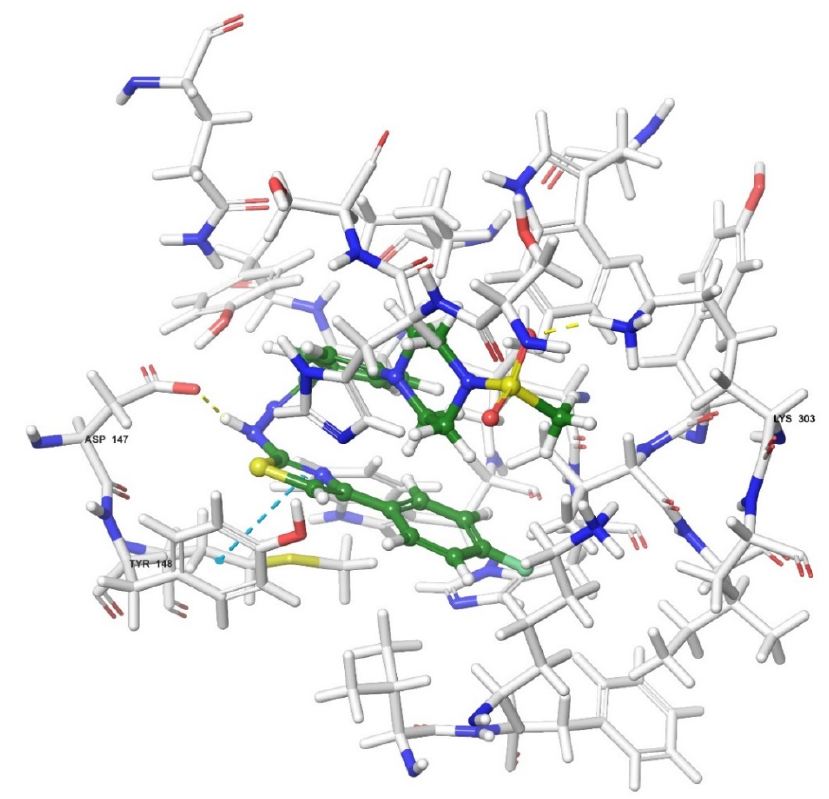
Figure 12. The three-dimensional interacting mode of compound 3f in the active region of µ -opioid receptor. The ligand and significant residues of the active site of the receptor are presented by a tube model colored with green and white, respectively (PDB Code: 5C1M).